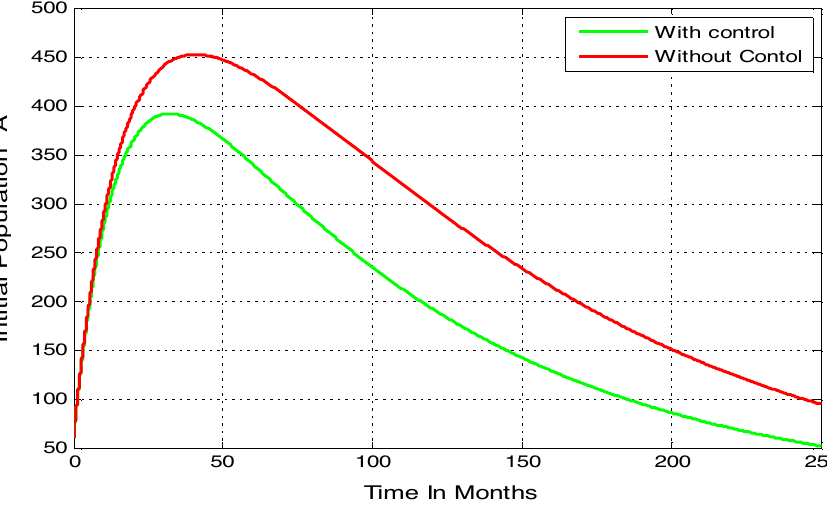
Figure 7. Variation in animosity infected students with and without both the controls.